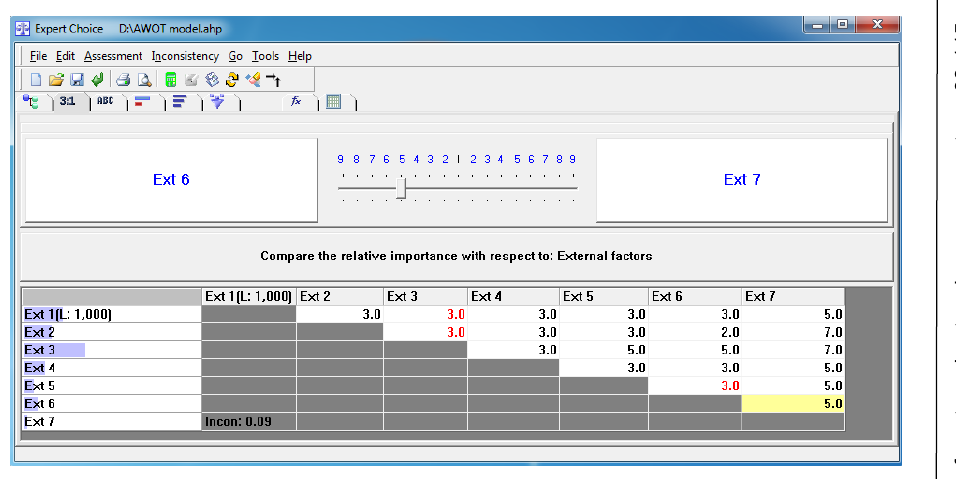
Figure 5 – Pairwise comparison of factors Ext 6 and Ext 7 and the priorities of the external factors